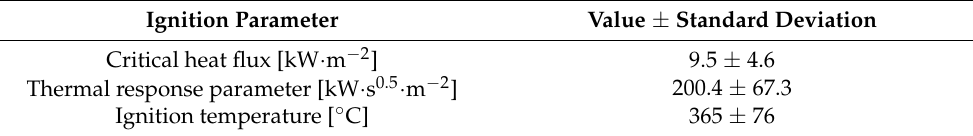
Table 9. Average ignition parameters of torrefied